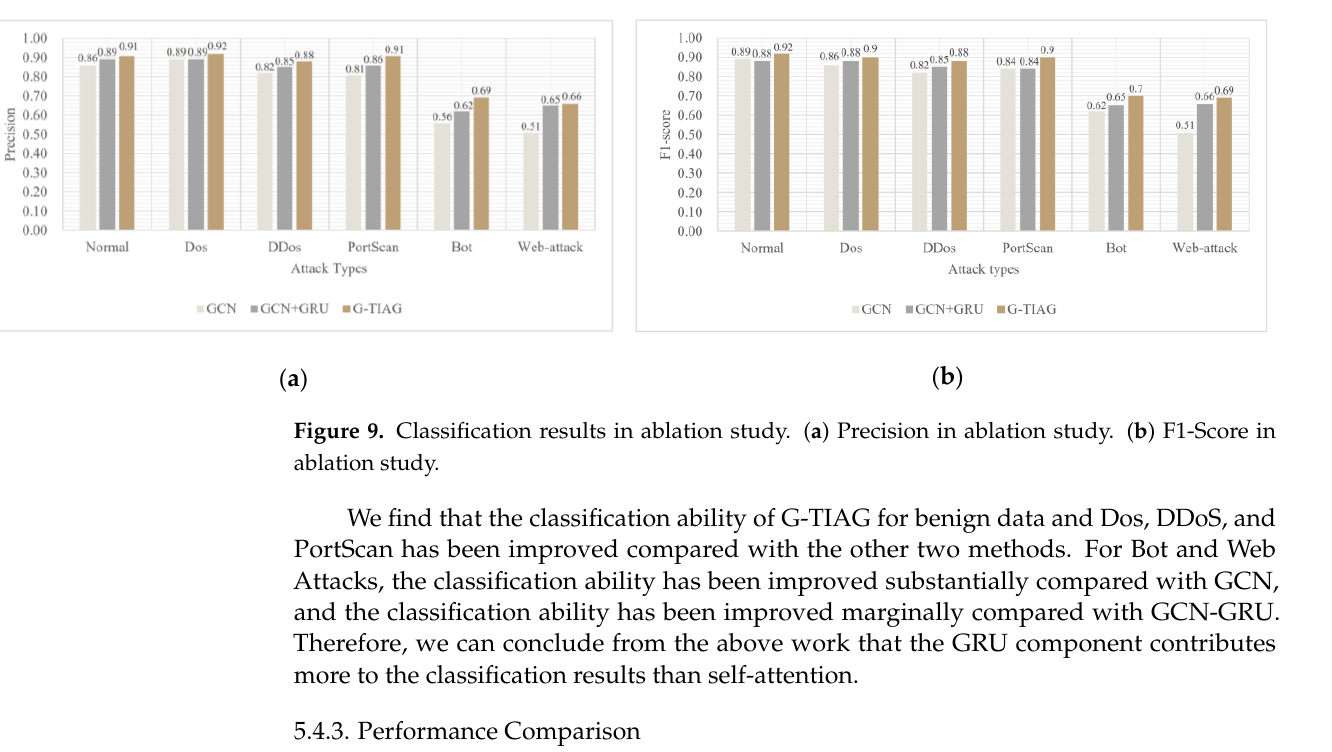
Table 8. Results of ablation study.